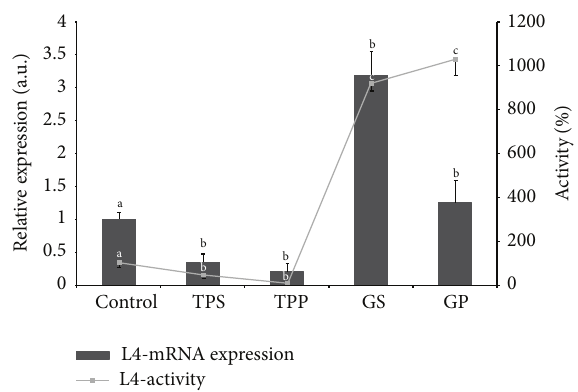
Figure 3: Comparison of relative activity of enzymes and expres- sion of four genes encoding the enzymes trehalose-6-phosphate synthase (TPS), trehalose-6-phosphate phosphatase (TPP), glyco- gen synthase (GS), and glycogen phosphorylase (GP) using the normalization reference gene ryb between L3 and L4 larval stages of Anisakis simplex . Different letters (a, b, and c) above the bars represent significant differences between L3 (control) and L4 of A. simplex for gene expression and enzyme activity. ¥ Data from Łopie´nska-Biernat et al. [25], 𝑟 = 0.95 for enzymes and mRNA of trehalose metabolism, 𝑟 = −0.8 for glycogen metabolism in L4 of A. simplex ( 𝑃 < 0.005 ) (as control 100% activity of enzymes was 0.43 ± 0.02 U/mg for TPS and 0.34 ± 0.03 for TPP U/mg in